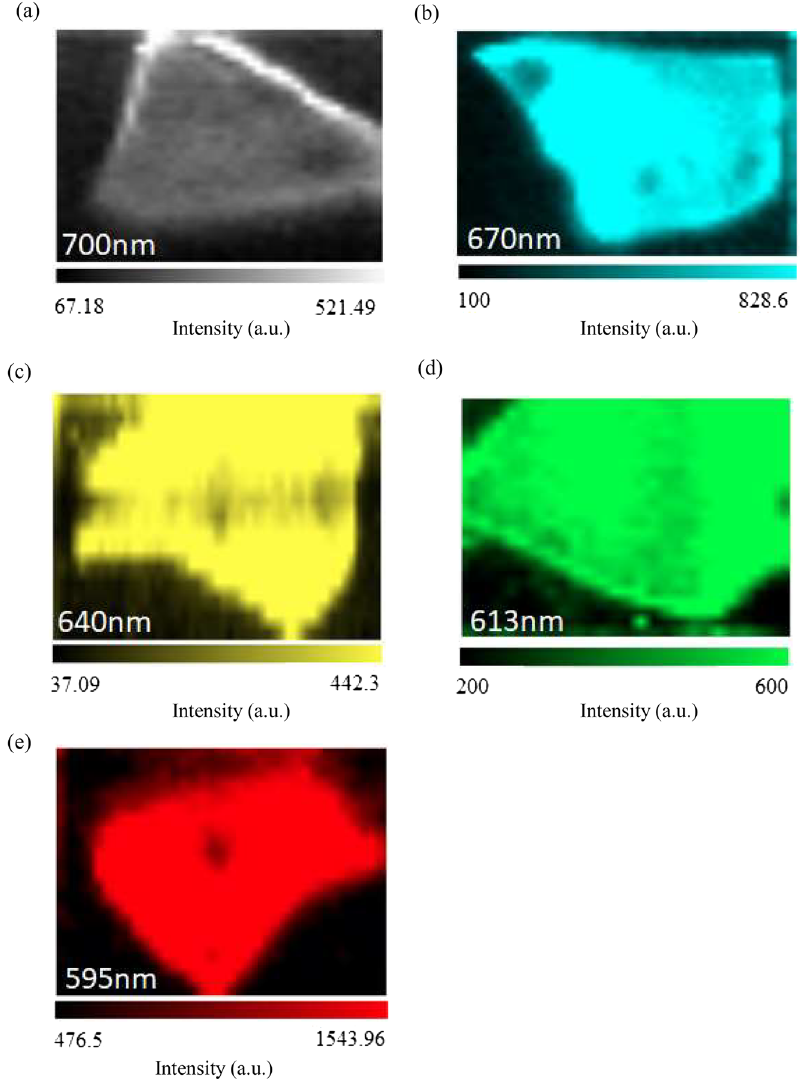
Figure 2: Spatial photoemission maps of different black phosphorus nanosheets showing the maximum light emission occurring at (a) 700 nm, (b) 670 nm, (c)640nm,(d)613nm,and(e)595nm.Each black phosphorus nanosheet is deposited on a different substrate and is treated at different treatment time